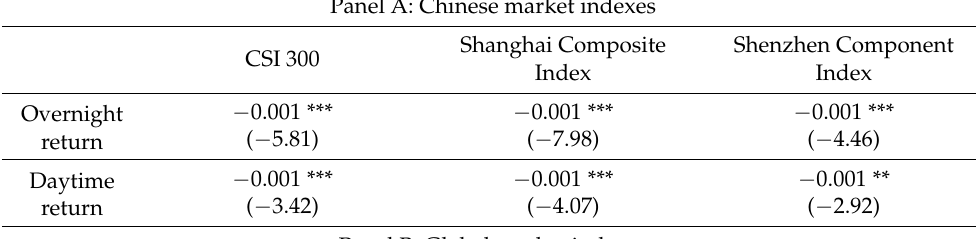
Panel B: Global market